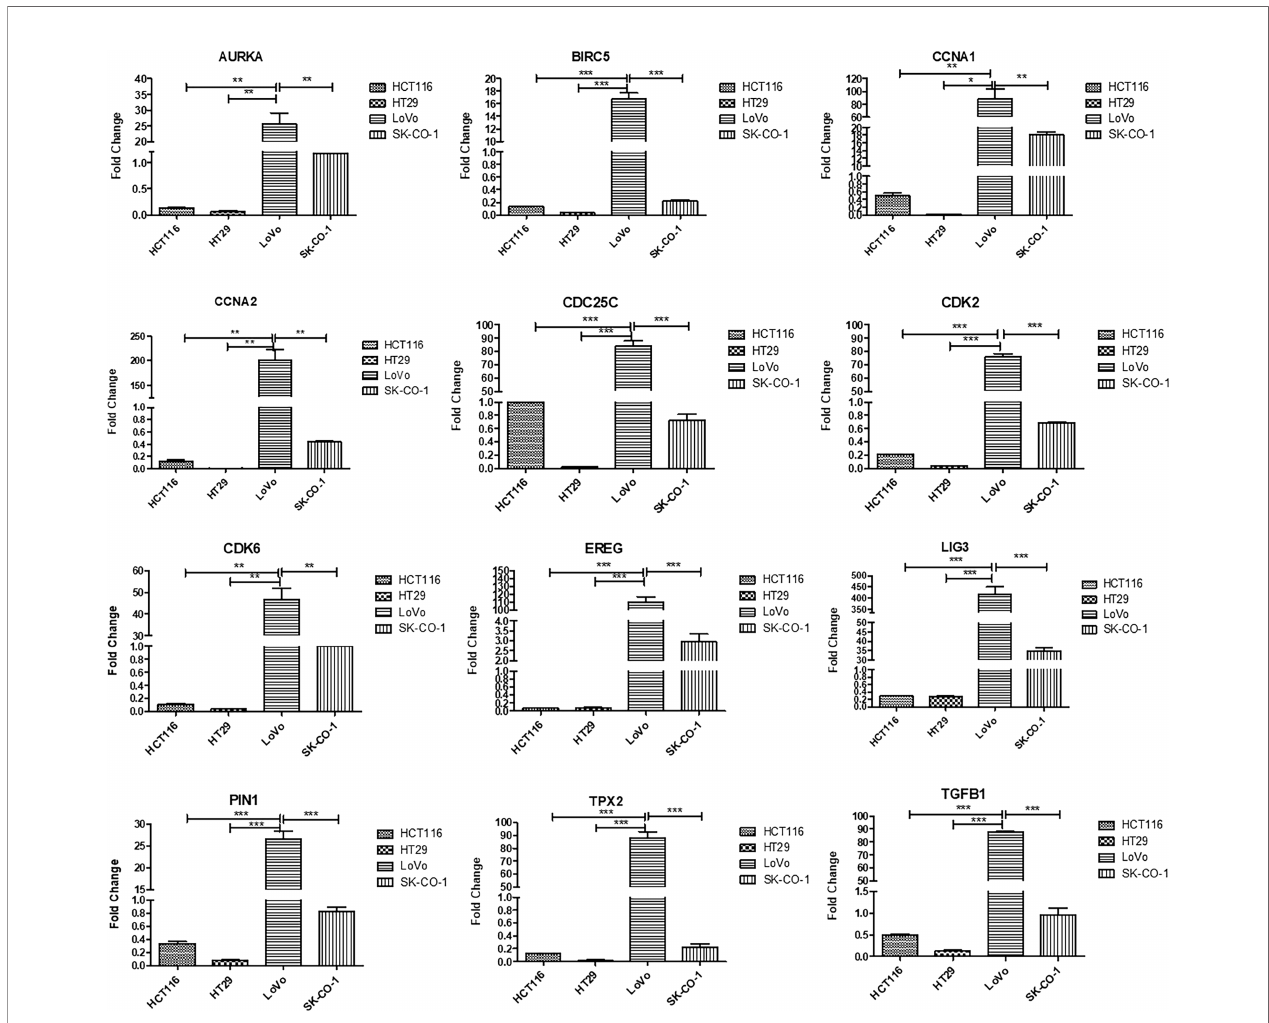
FIGURE 6 | Validation of top upregulated genes in metastatic CRC compared to earlier stages, using Real-time PCR for four cell lines; HCT116, HT29, LoVo and SK-Co-1. The cells were starved overnight to ensure synchronization. Gene expression in each cell line was normalized to its corresponding non-starved cell line. One way ANOVA was used to compare the expression among different cell lines. Metastatic cell lines; LoVo and SK-Co-1 showed signi fi cantly higher expression of AURKA, BIRC5, CCNA1, CCNA2, CDK2, CDK6, EREG, LIG3, PIN1, TGFB1, TPX2 , compared to their expression in HCT116 and HT29. In contrast, CDC25C was also highly expressed in HCT116. * denotes p-value <0.05, ** denotes p-value <0.01, *** denotes p-value